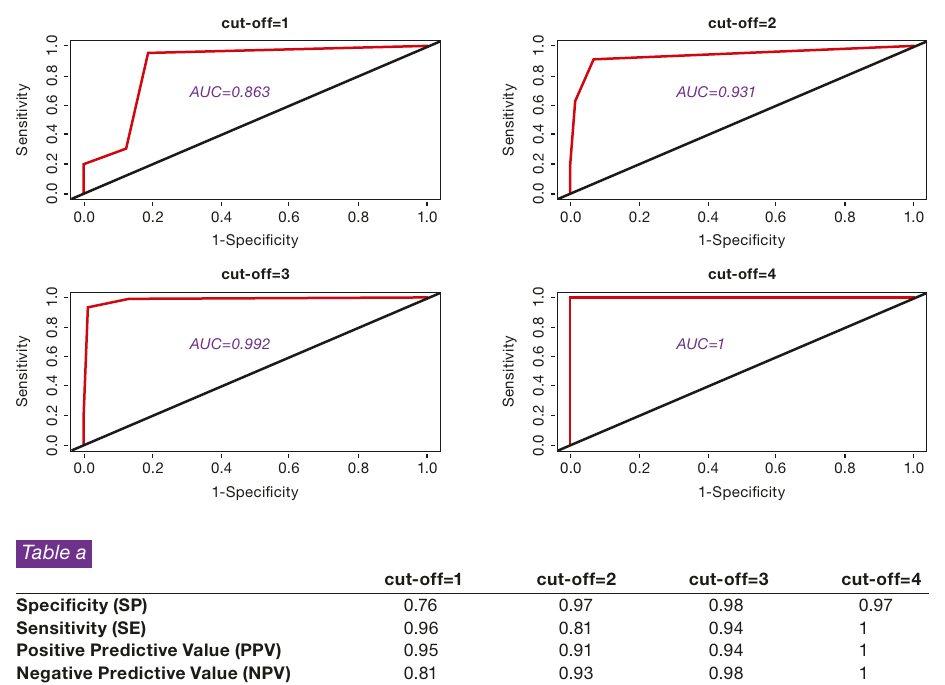
cut-off=1 cut-off=2 cut-off=3 cut-off=4 Specificity (SP)